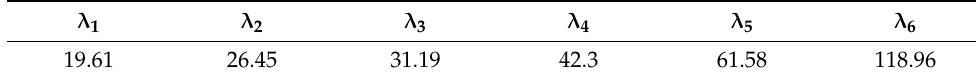
Table 4. Eigenvalues of the elasticity matrix C of LiAl(IO 3 ) 4 , in